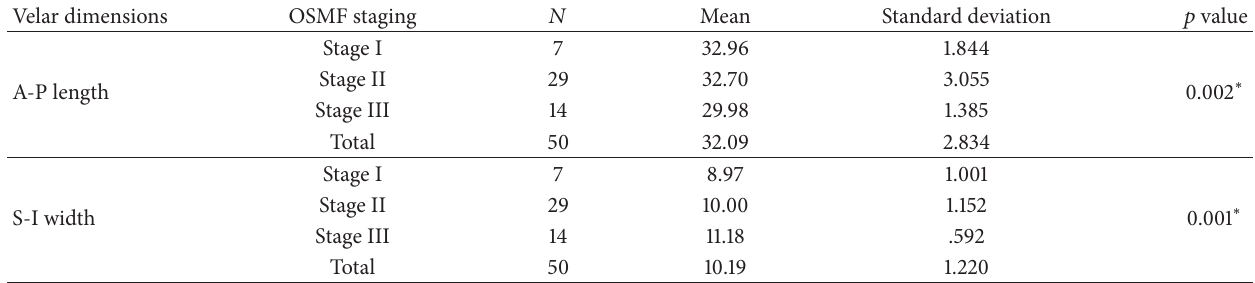
Table 4: The mean anteroposterior (A-P) length and superoinferior (S-I) width of soft palate patterns according to stagewise distribution of OSMF using Kruskal Wallis test.